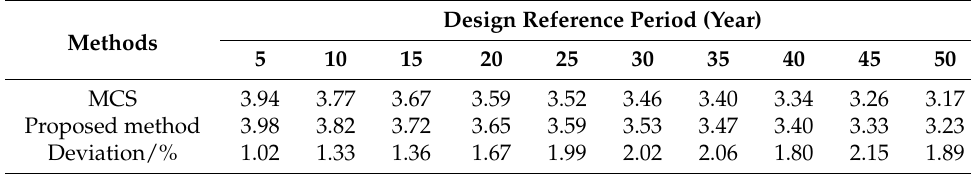
Table 5. Reliability index of each design reference period of the short